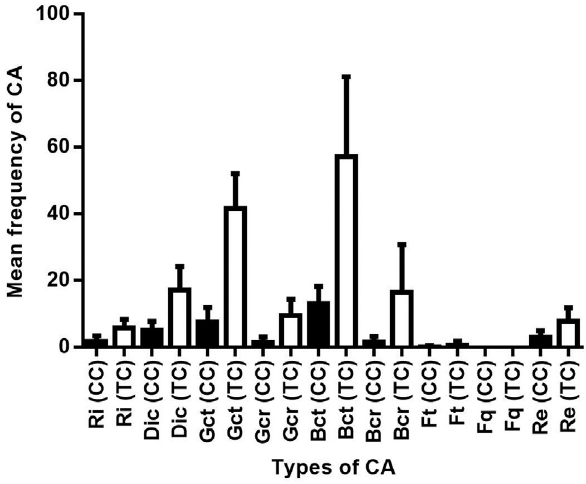
Figure1 -Meanfrequencyofthetypesofchromosomalaberrations(CAs) analysed in control cell cultures (CC, black bars) and doxorubicin-treated cell cultures (TC, white bars) for female and male deer, in each experi- ment. Types of chromosomal aberrations: ring (Ri), dicentric (Dic), chro- matid gap (Gct), chromosome gap (Gcr), chromatid break (Bct), chromo- some break (Bcr), triradial form (Ft), quadriradial form (Fq) and rearrangement